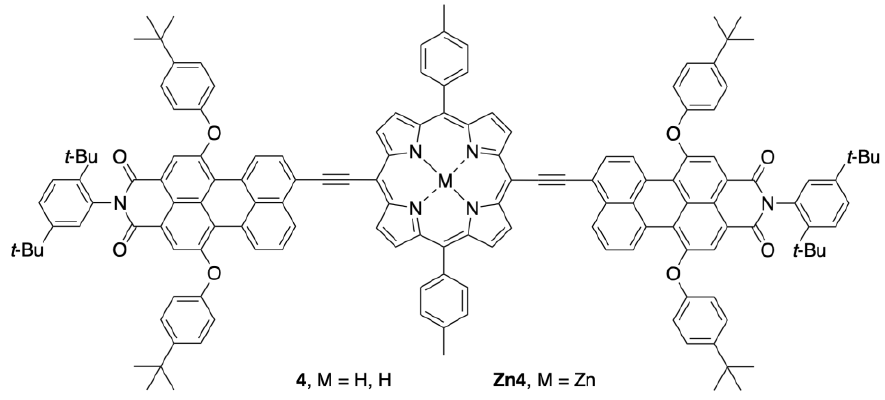
Figure 1. Absorption spectra of a perylene-ethynyl-porphyrin dyad ( 1 , solid red line), to be com- pared with phenylethynyl-porphyrin ( 2 , solid blue line) and perylene-ethyne ( 3 , solid orange line) constituents (in toluene at room temperature). The fluorescence spectrum of 1 also is shown (dashed red line;  em 695 nm) [42]. The absorption spectrum of the perylene-ethynyl-porphyrin dyad 0 (dot- ted black trace [41]) is essentially identical with that of analogous dyad 1 (solid red line).